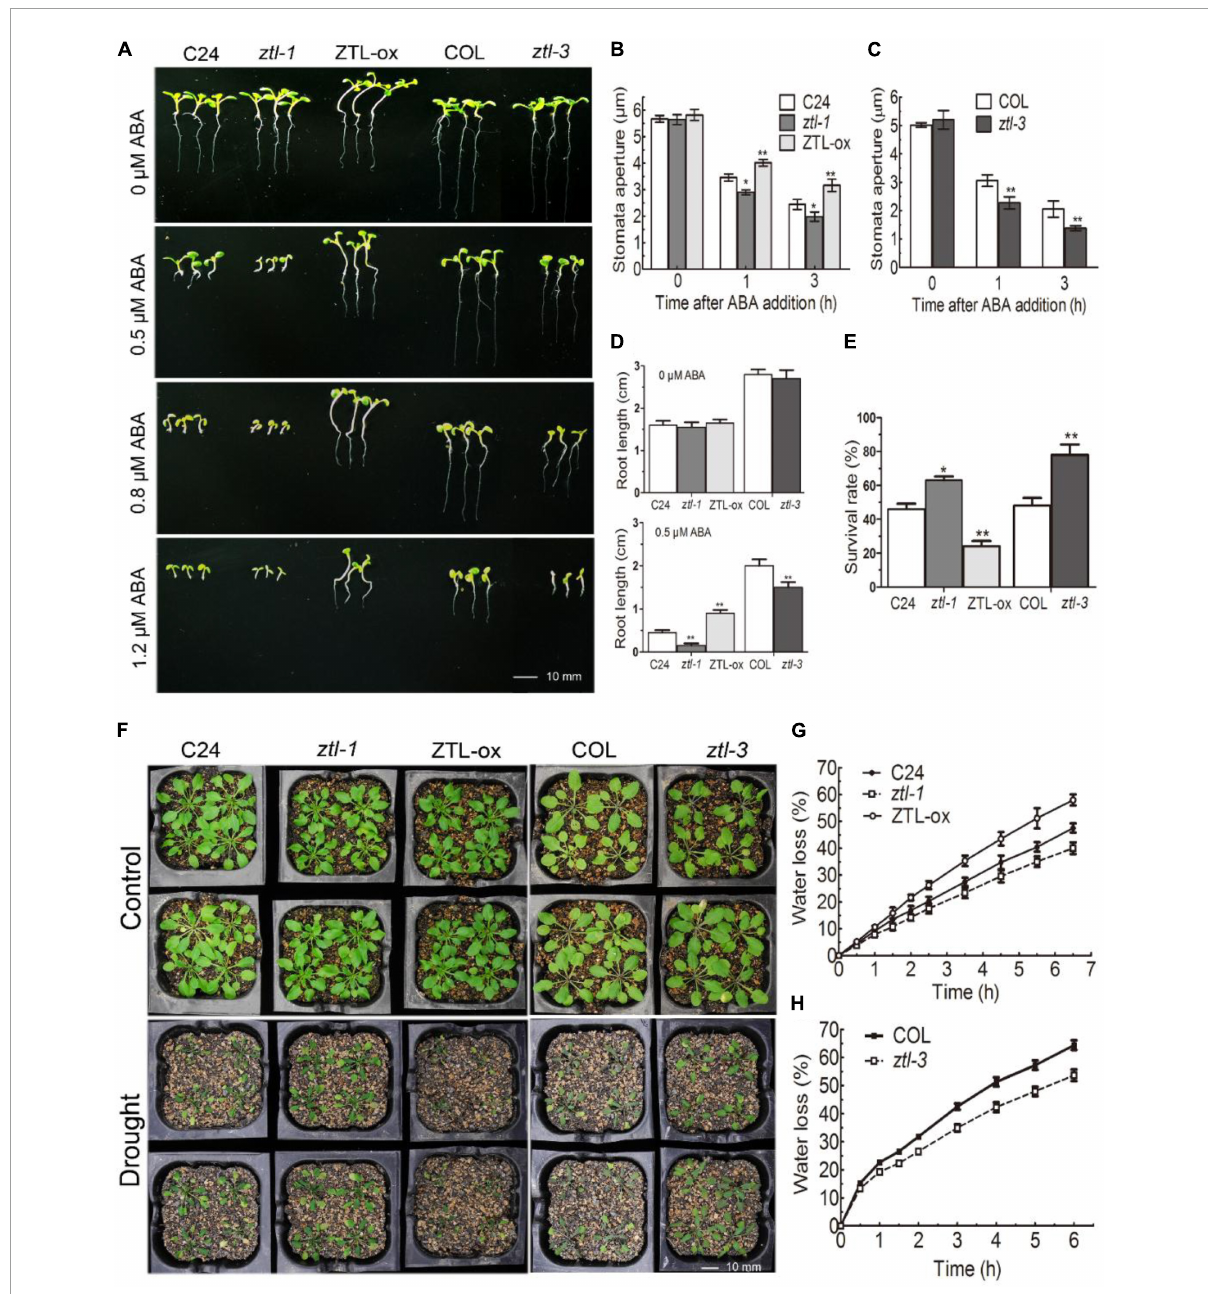
FIGURE2 ZTL negatively regulates ABA signaling. (A) Comparative photographs of ten-day-old C24, ztl-1 (C24), ZTL-ox (C24), Col and ztl-3 (Col), seedlings grown on MS plates containing 0, 0.5, 0.8 or 1.2 µ M ( ± ) ABA. (B,C) Stomatal apertures of C24, ztl-1 , ZTL-ox (B) , Col and ztl-3 (C) ). Stomatal apertures were measured before ABA treatment and 1 or 3 h after ABA treatment. Data are the means ± SE from four independent experiments with 60 apertures per genotype and per treatment (with significant differences at * P < 0.05, ** P < 0.01). (D) Statistics of the primary root lengths of the plants as described in (A) . Student’s t -test was used to compare the primary root lengths of each mutant or transgenic line with their corresponding WT plants (with significant differences at ** P < 0.01). (E) The survival rates of C24, ztl-1 , ZTL-ox, Col and ztl-3 as mentioned in (F) . Plants were subjected to progressive drought by withholding water for 2 weeks, and survival rates were recorded 2 days after the plants were re-watered. Data are the means ± SE of 5 independent experiments with at least 96 plants for each genotype (with significant differences at * P < 0.05, ** P < 0.01). (F) Whole-plant status in drought tolerance assay for C24, ztl-1 , ZTL-ox, Col and ztl-3 plants. Plants were well watered (Control) or drought stressed by withholding water (Drought) for 2 weeks. The experiments were repeated five times with similar results. (G,H) Water loss rates during a 6.5/6-h period from the detached leaves of C24, ztl-1 , ZTL-ox (G) , Col and ztl-3 (H) plants. Each value is the mean ± SE of three biological